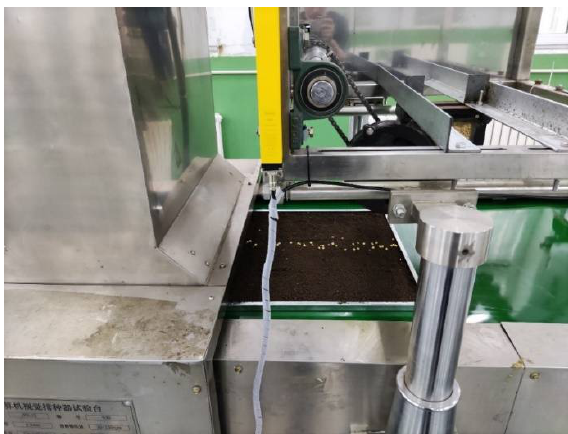
Figure 16. Computer vision seeding test bench.